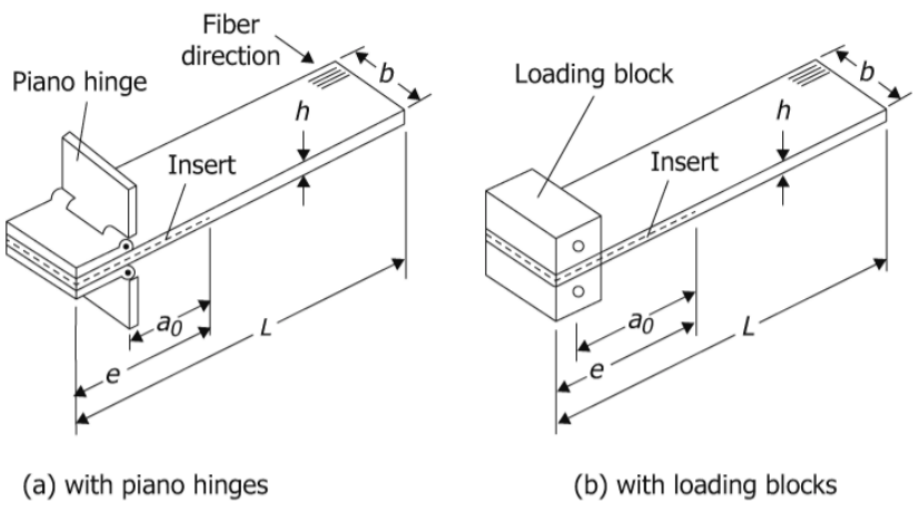
Figure 1. Standardised DCB specimens according to the ASTM D5528-13 [41]: ( a ) with piano hinges and ( b ) with loading blocks. Reprinted, with permission, from ASTM D5528-13 [41] Standard Test Method for Mode I Interlaminar Fracture Toughness of Unidirectional Fibre-Reinforced Polymer Matrix Composites, copyright ASTM International. A copy of the complete standard may be obtained from